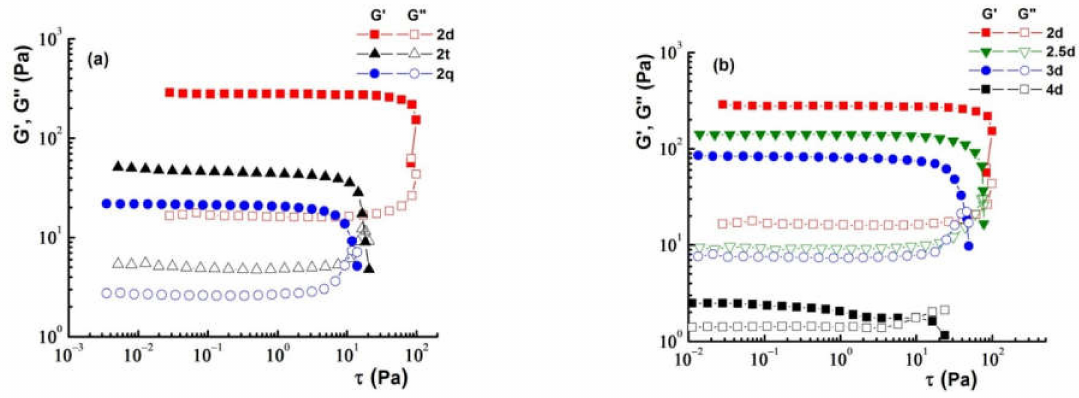
Figure 6. Effect of ( a ) water content in hydrogel and ( b ) P5P amount on the linear viscoelastic regime at 37 ◦ C and 10 rad s − 1